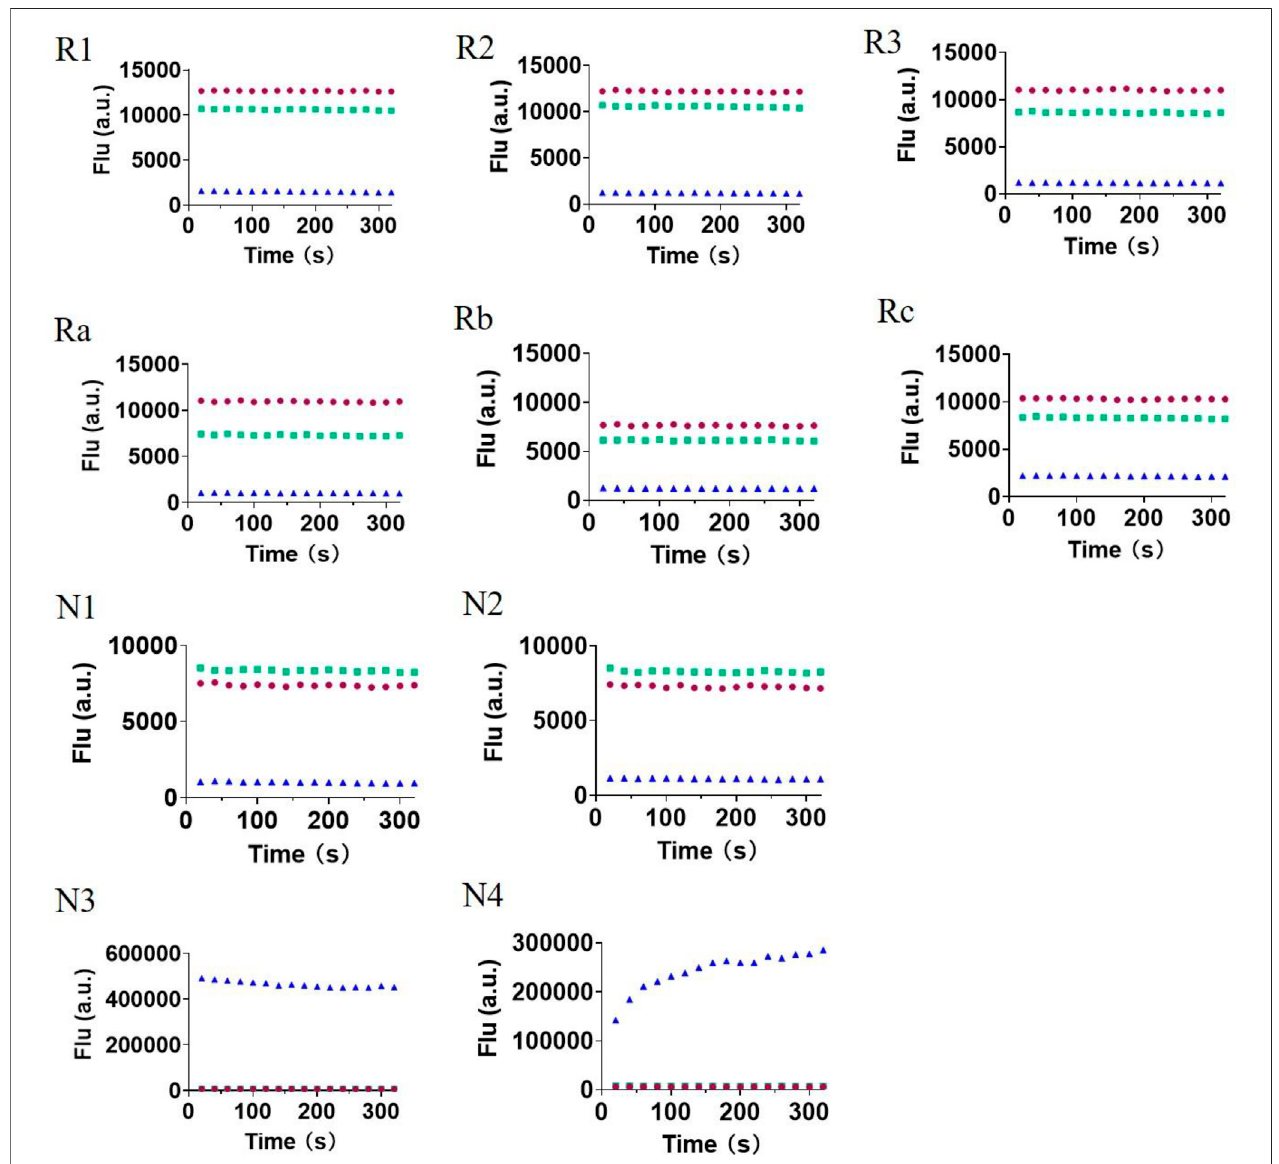
FIGURE 3 | The fl uorescence intensity of all 10 probes ( R1 – N4 ) in various phosphate buffers with different pHs (pH3, red; pH7, green; and pH13, blue). Once the compounds were dissolved, fl uorescence intensity was immediately measured for several minutes.